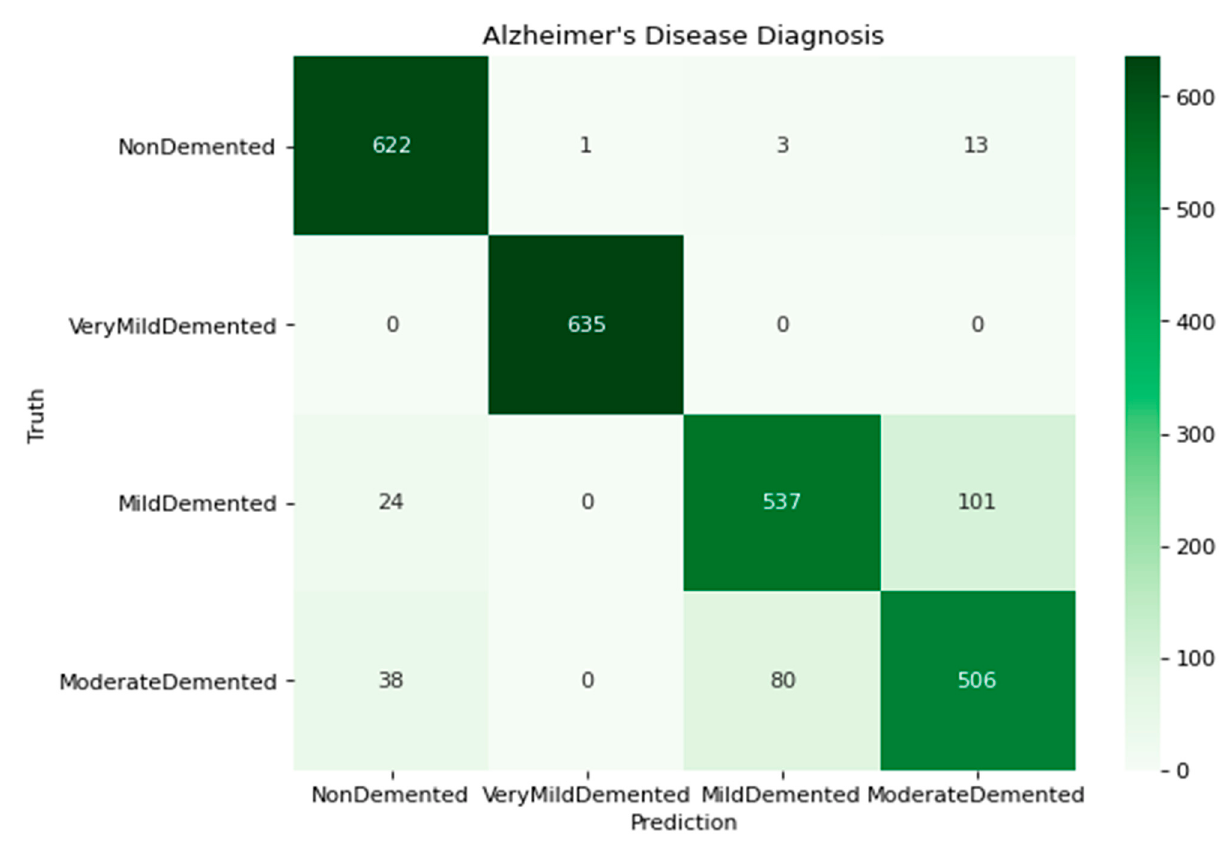
Figure 4. Confusion matrix of the model with four classes. Table 3. Performance analysis with different approaches.